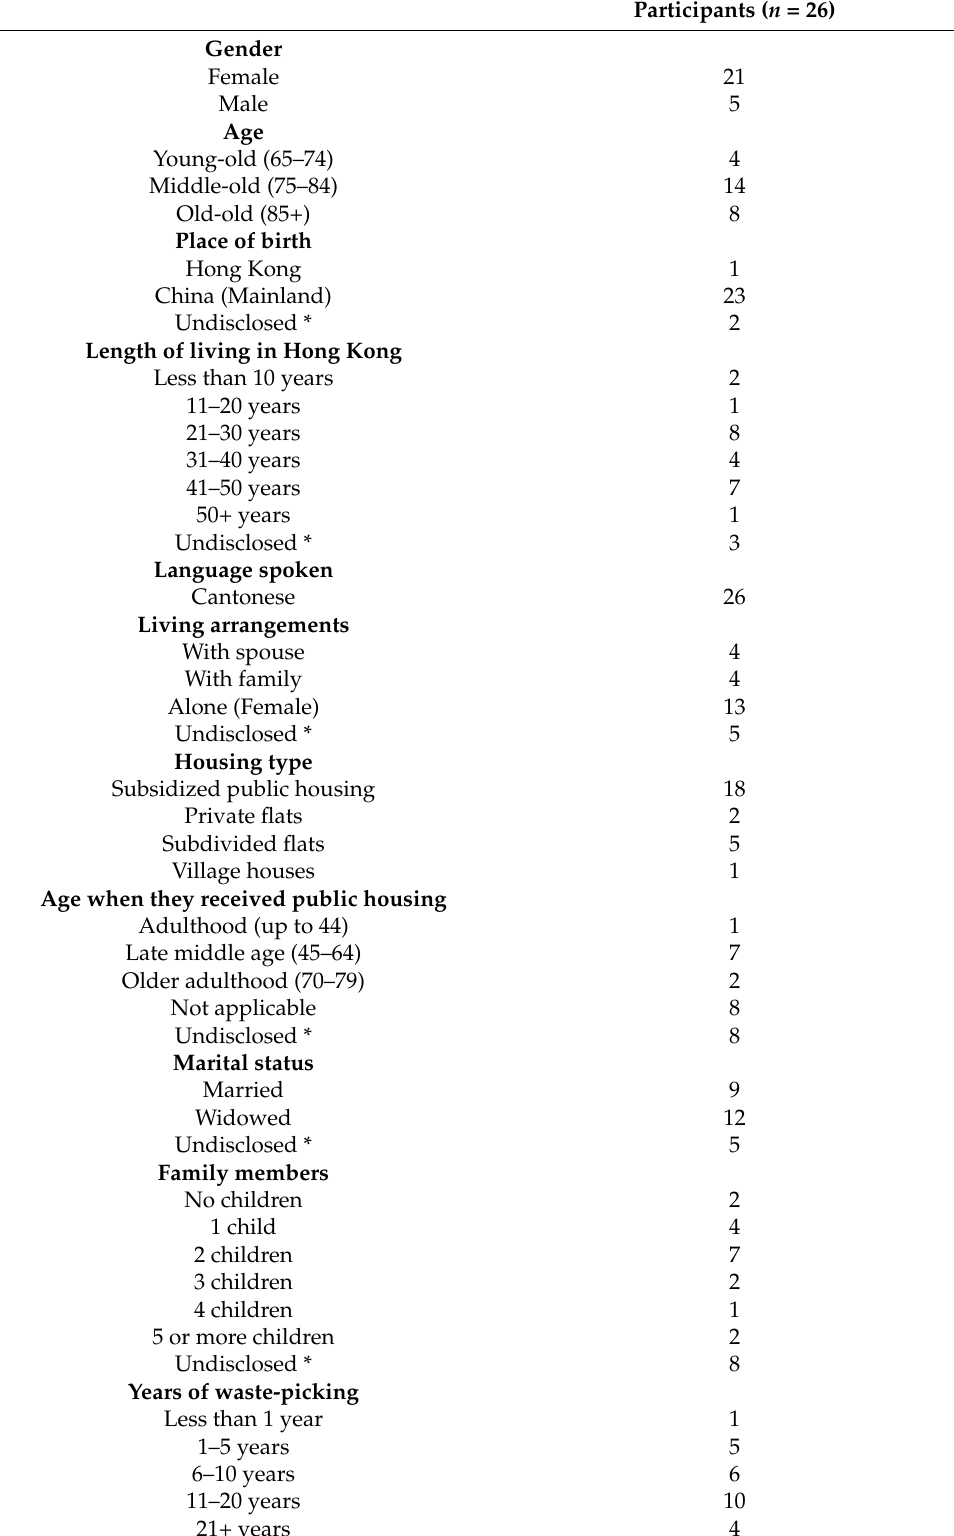
Table A1. Participant Characteristics of Older Adult